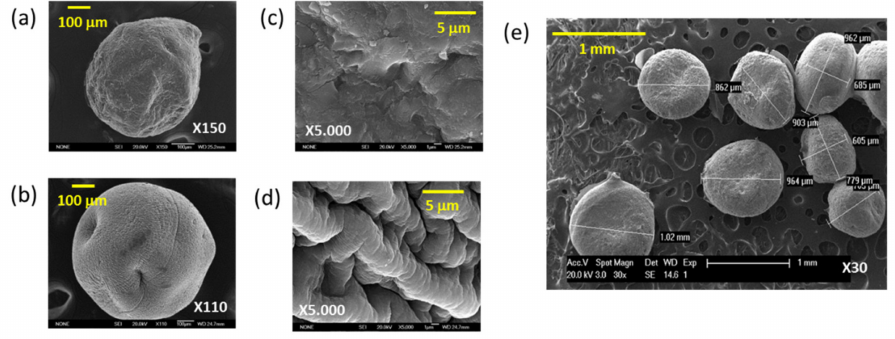
Figure 4. ( a , b ) Scanning electron microscope (SEM) image of Ch/TPP ( a ) and Ch/TPP/Alg beads ( b ); ( c , d ) Magnified view of Ch/TPP ( c ) and Ch/TPP/Alg beads ( d ); ( e ) Ch/TPP/Alg morphology.